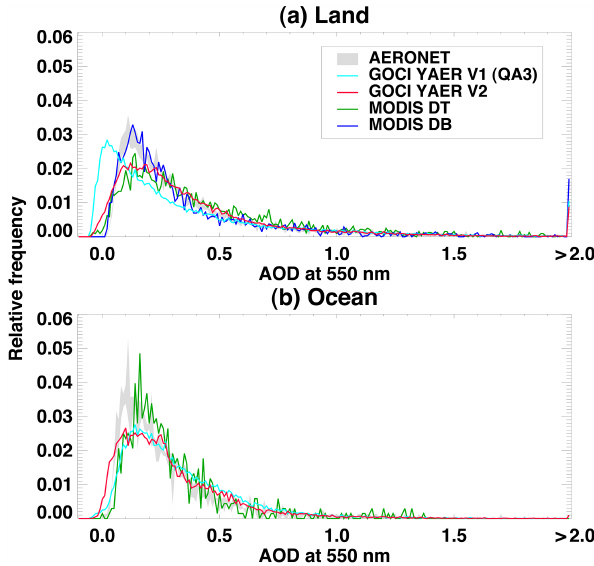
Figure 4. Relative frequency histograms of retrieved AOD from AERONET and satellites over (a) land and (b) ocean